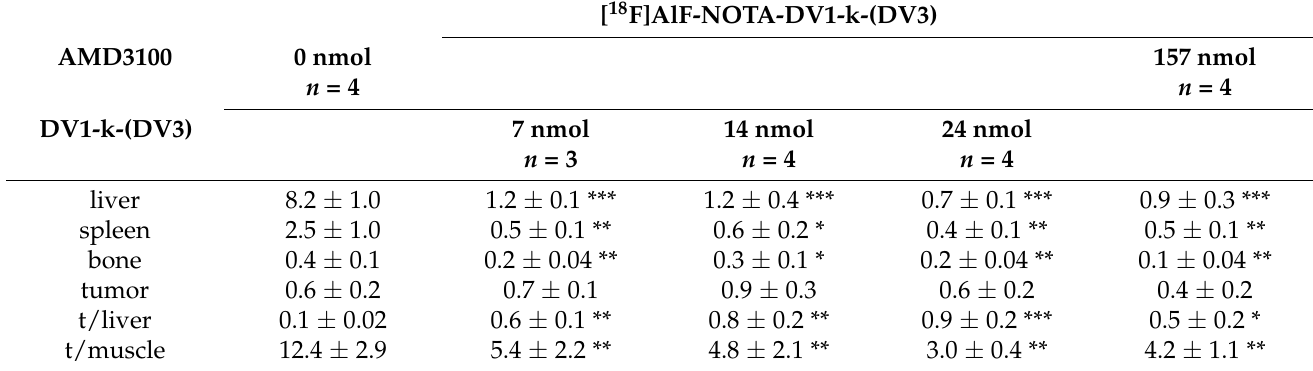
Table 5. Increased mass of DV1-k-(DV3). Ex vivo biodistribution in U87.hCXCR4 tumor-bearing mice 75 min p.i. (expressed in SUV). Statistical analysis independent-samples t -test. All data are expressed as mean ± SD. * p < 0.05, ** p ≤ 0.01, *** p ≤ 0.001.